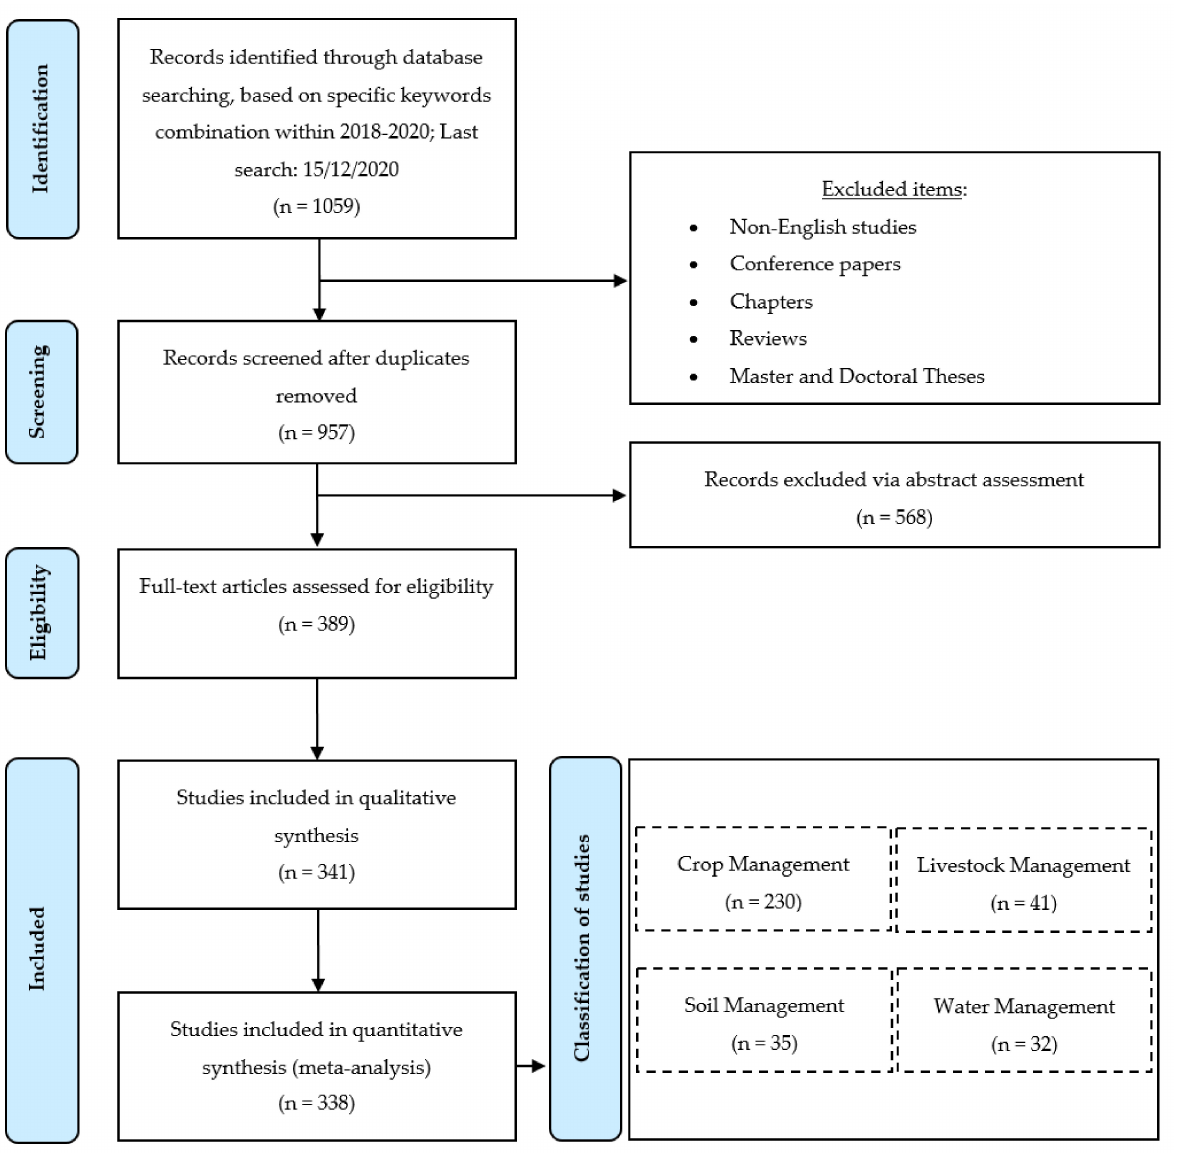
Figure 3. The flowchart of the methodology of the present systematic review along with the flow of information regarding the exclusive criteria, based on PRISMA guidelines